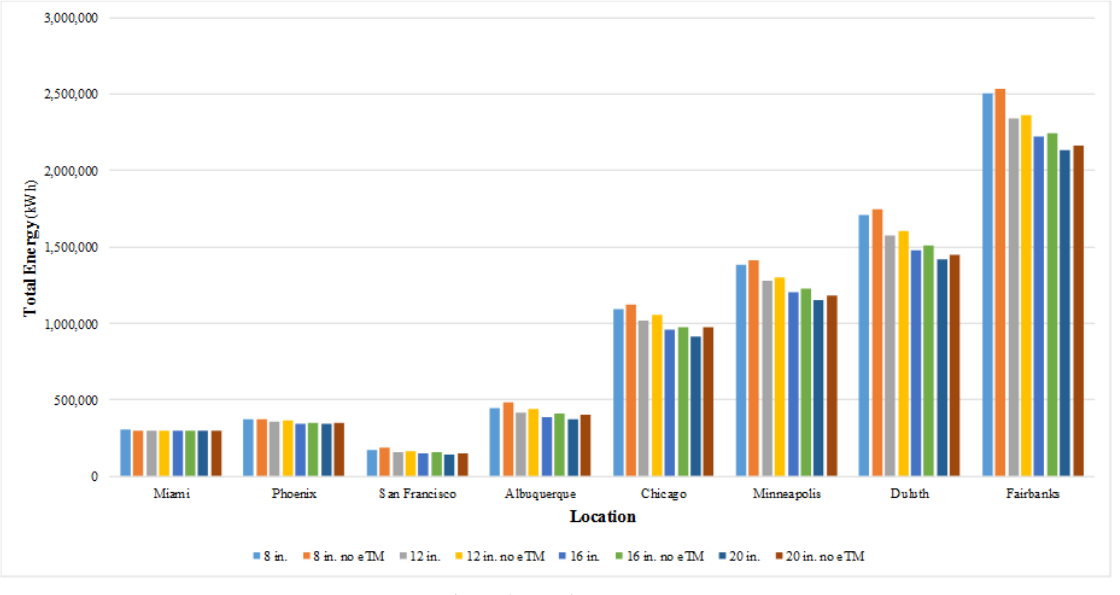
Figure 3. Total energy use Table 5 indicates the percentage reduction and/or increase of total energy use for all wall thickness